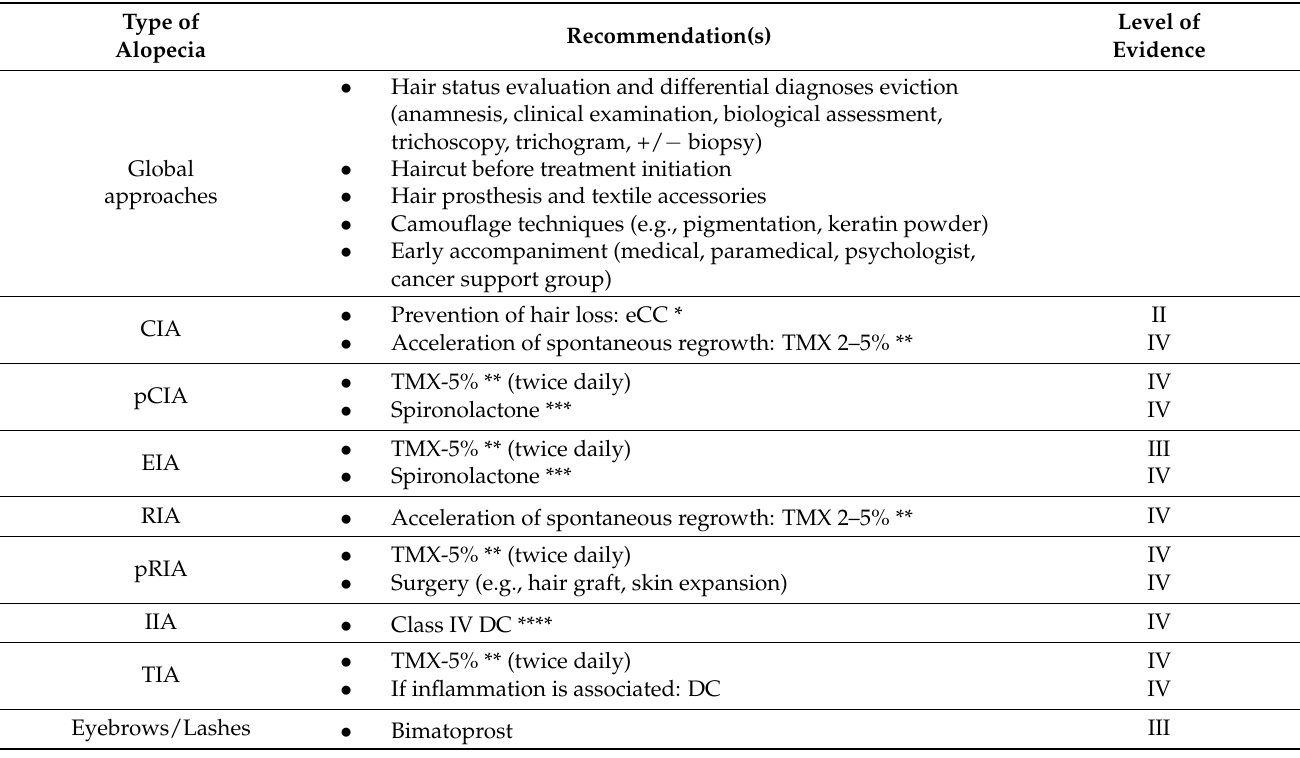
Table 6. Currently issued recommendations for the management of ANIA based on the literature (adapted from references